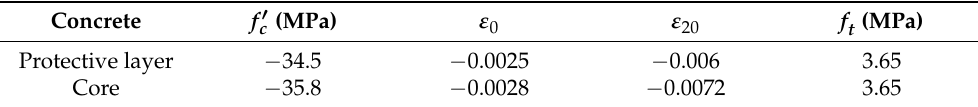
Table 1. Parameters of the concrete